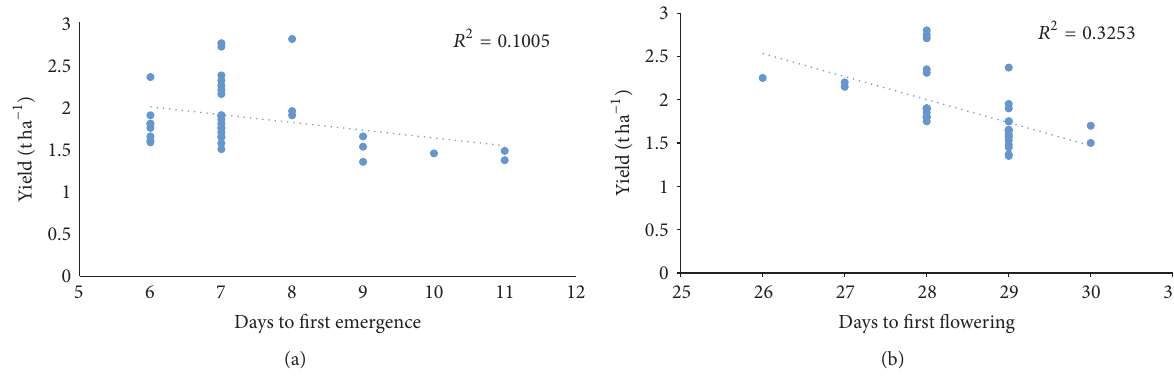
Figure 2: Relationship between days to first emergence and first flowering on yield of peanut (mean of two trials).